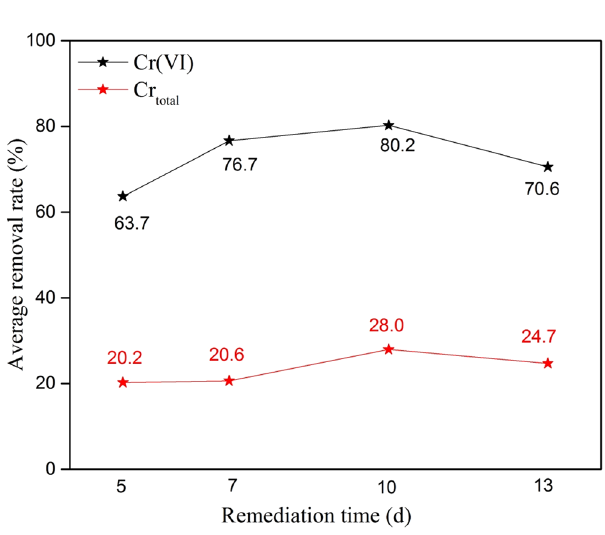
Figure 6. Effect of the remediation time on the Cr removal efficiency in the 3D EKR experiment.